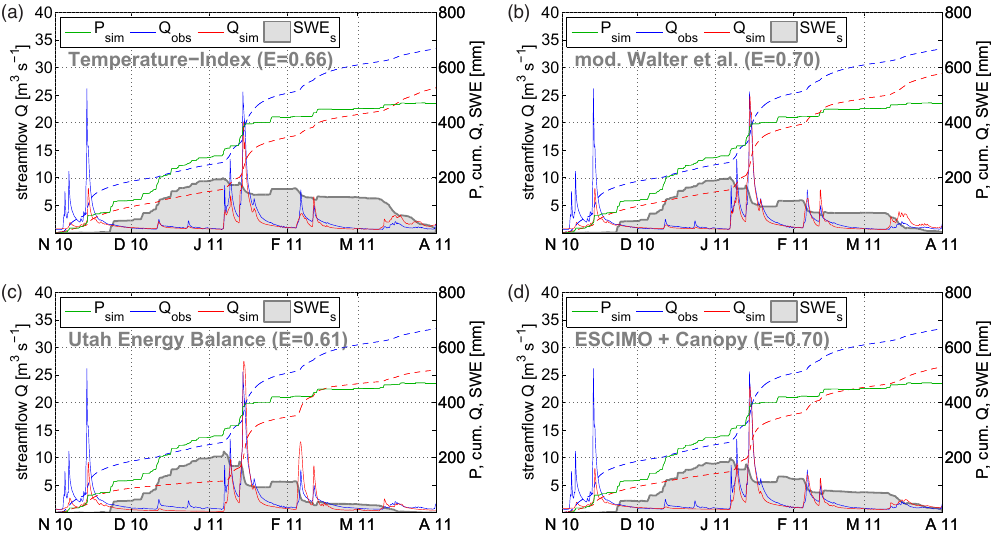
Figure 13. Streamflow simulations at the catchment scale using downscaled meteorological time series for the winter season 2010–2011: (a) temperature-index approach, (b) modified Walter et al. (2005) approach, (c) Utah Energy Balance model, and (d) ESCIMO + Canopy. For every simulation run, downscaled precipitation depth ( P sim ), observed streamflow ( Q obs , blue line), observed runoff depth (blue dashed line), simulated streamflow ( Q sim , red line), simulated runoff depth (red dashed line), and simulated snow water equivalent (SWE s ) are plotted. Model efficiencies E are also given for each